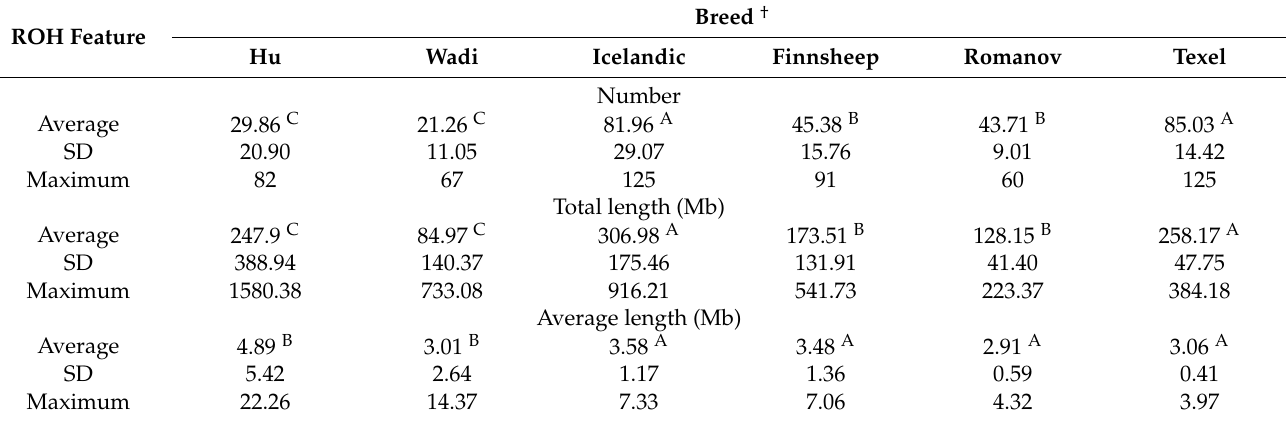
Table 2. Runs of homozygosity (ROH) feature of six sheep breeds.